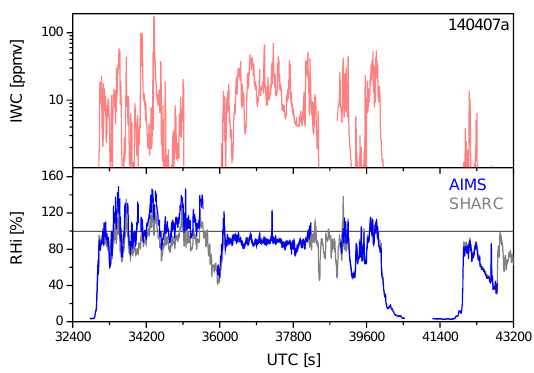
Figure 10. Top: ice water content (IWC) as cloud marker derived from total water measurements by the WARAN tunable diode laser instrument. Bottom: relative humidity with respect to ice calculated from AIMS H 2 O mixing ratios (blue curve) and SHARC mixing ratios (gray curve) using the HALO static air temperature measure- ment. Except for the middle part from 36000 to 38000s where the in-cloud RHi is below 100%, RHi typically scatters around satura- tion inside the clouds.